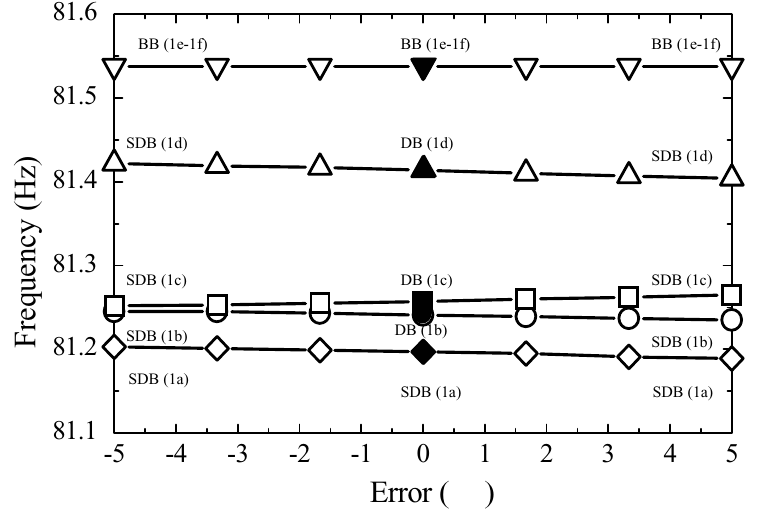
Fig. 8. Frequencies varying with the mistuned error for a six-blade